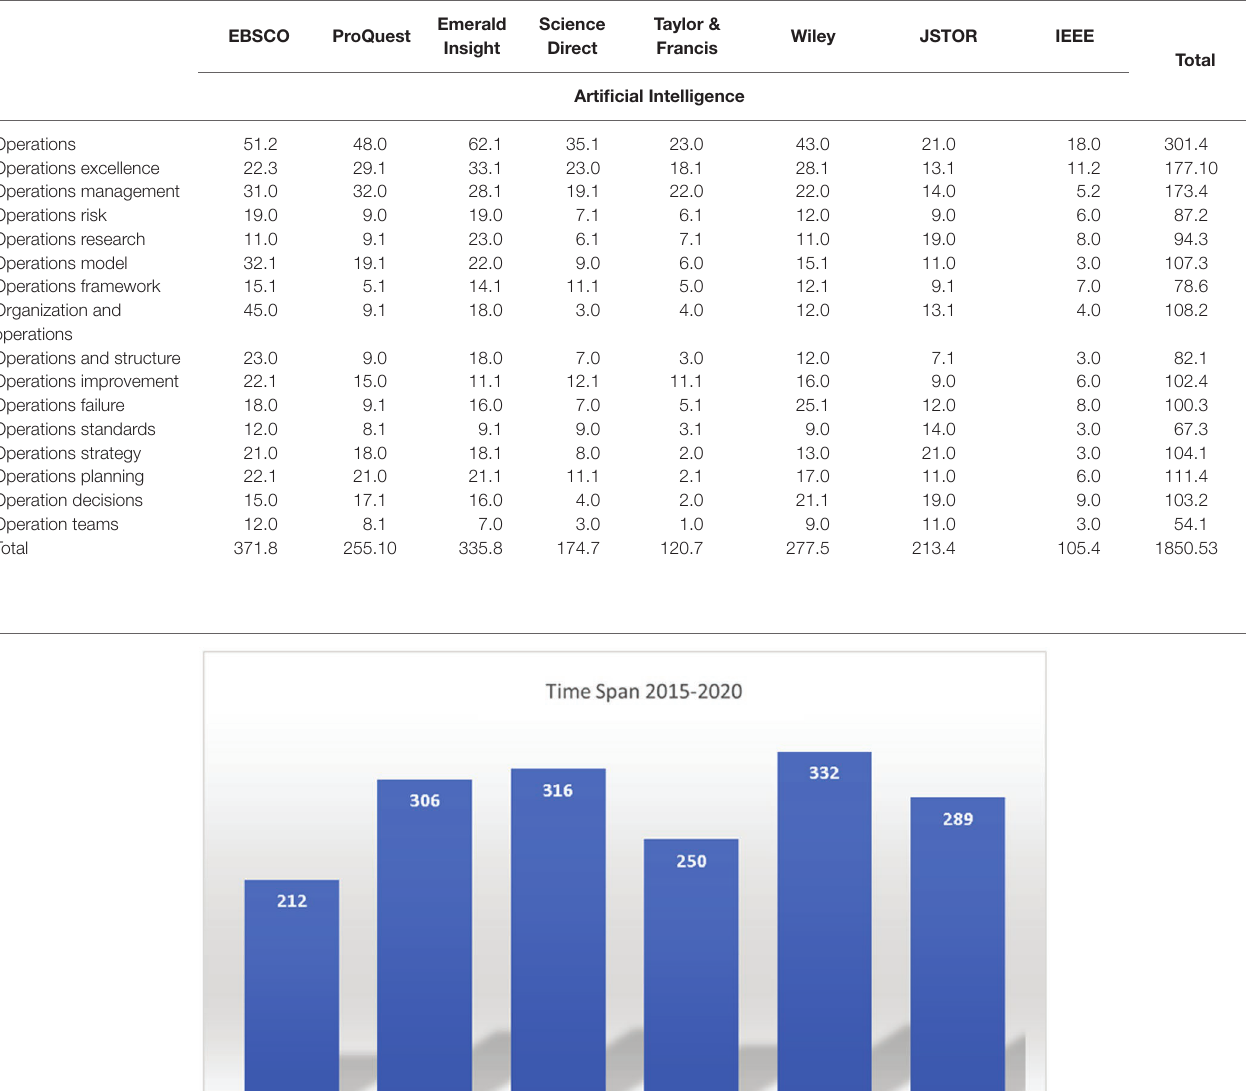
TABLE 1 | Database search and Processing